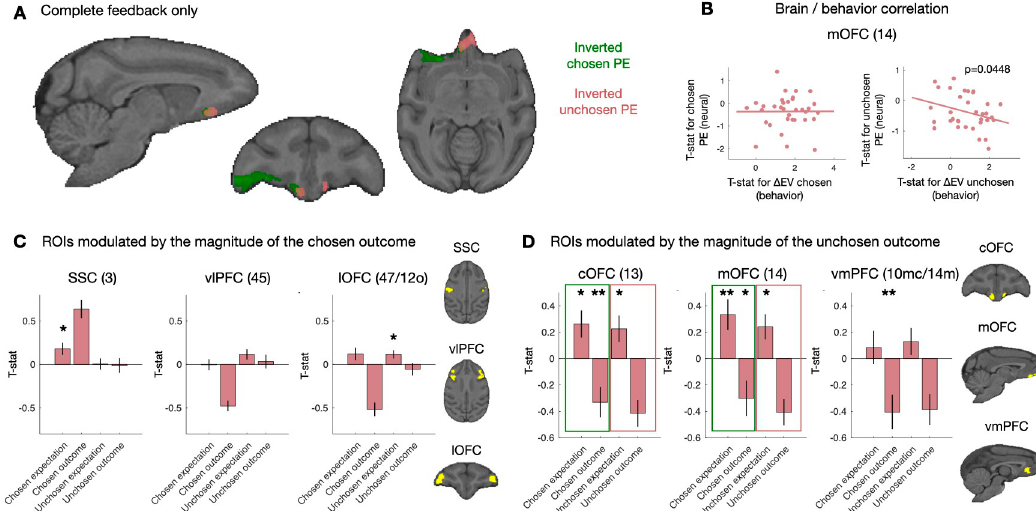
Fig 5. Prediction error neural results. ( A ) In complete feedback sessions only, we found clusters for inverted prediction error activity in the central part of OFC (area 13), extending into lOFC (area 47/12o). We also found inverted prediction error activity in the cOFC (area 13) and mOFC (area 14) for the unchosen, counterfactual reward. ( B ) Brain–behavior correlational analysis between the prediction error signal in the mOFC (t-statistic) and session-specific t-statistic of the behavioral effect of the change in expected value on choices (estimated with a separate GLM for each session). ( C ) We placed ROIs (in yellow) in the overlap of the functional cluster modulated by the magnitude of the chosen outcome and anatomical region. We extracted t-statistics for reward and expectation, both of the chosen and unchosen option. Prediction error activity should evoke both a reward and an expectation response with opposite signs. We did not found evidence for outcome expectation of the chosen option. Mean across complete feedback sessions (34 sessions). ( D ) When defining the ROIs (in yellow) according to the response to the magnitude of unchosen outcome, we find evidence for a classic reward prediction error and a counterfactual prediction error about the unchosen option both in cOFC and mOFC: We observe activity related both to the obtained and the unobtained reward, and also activity related both the chosen and unchosen outcome expectation. Mean across complete feedback sessions (34 sessions). Error bars represent standard error to the mean. � p < 0.05, �� p < 0.01. Data and code to reproduce the figure can be found at https://doi.org/10.5281/ zenodo.7464572. cOFC, central OFC; GLM, general linear model; OFC, orbitofrontal cortex; lOFC, lateral OFC; mOFC, medial OFC; ROI, region of